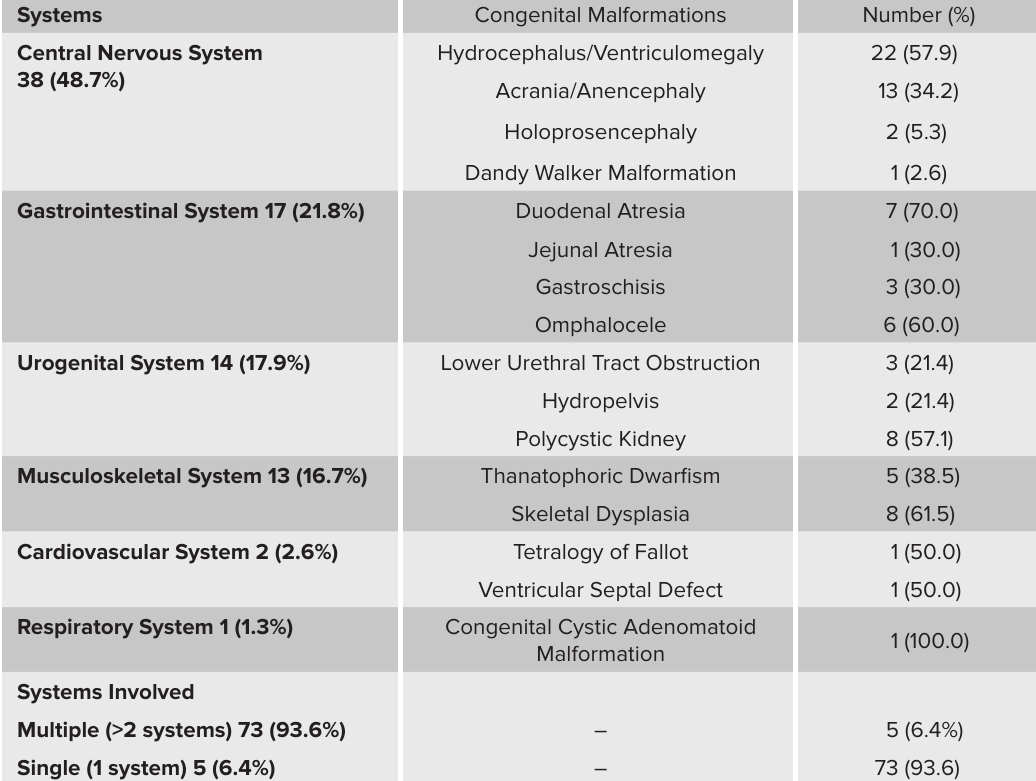
Table 2: Spectrum of Major Congenital